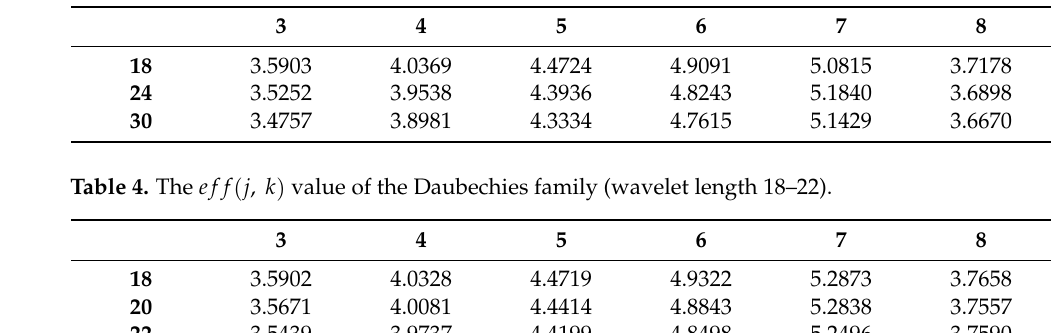
Table 3. The ef f ( j , k ) value of the Coiflets family (wavelet length 18–30).